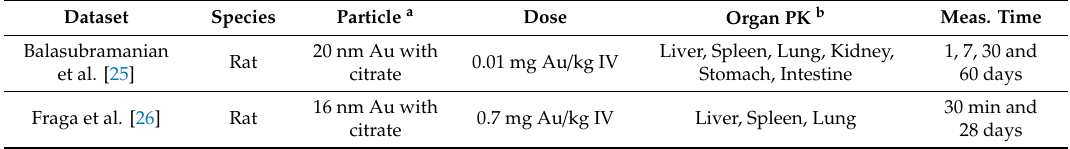
Table 2. Experimental datasets from literature used for model